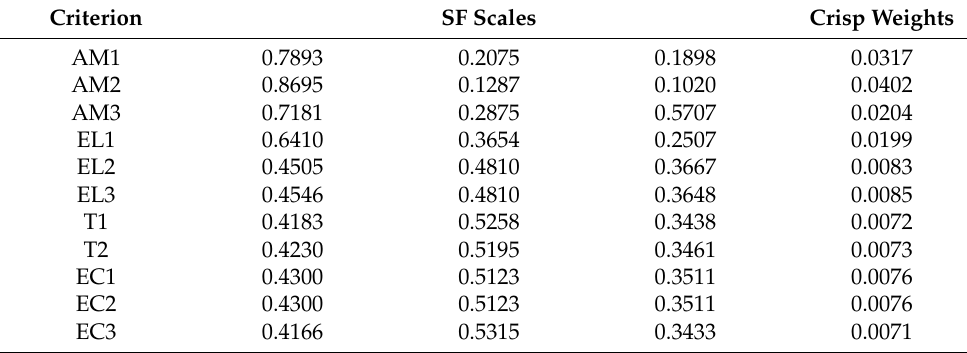
Table 4. Findings of the Spherical Fuzzy Analytic Hierarchy Process